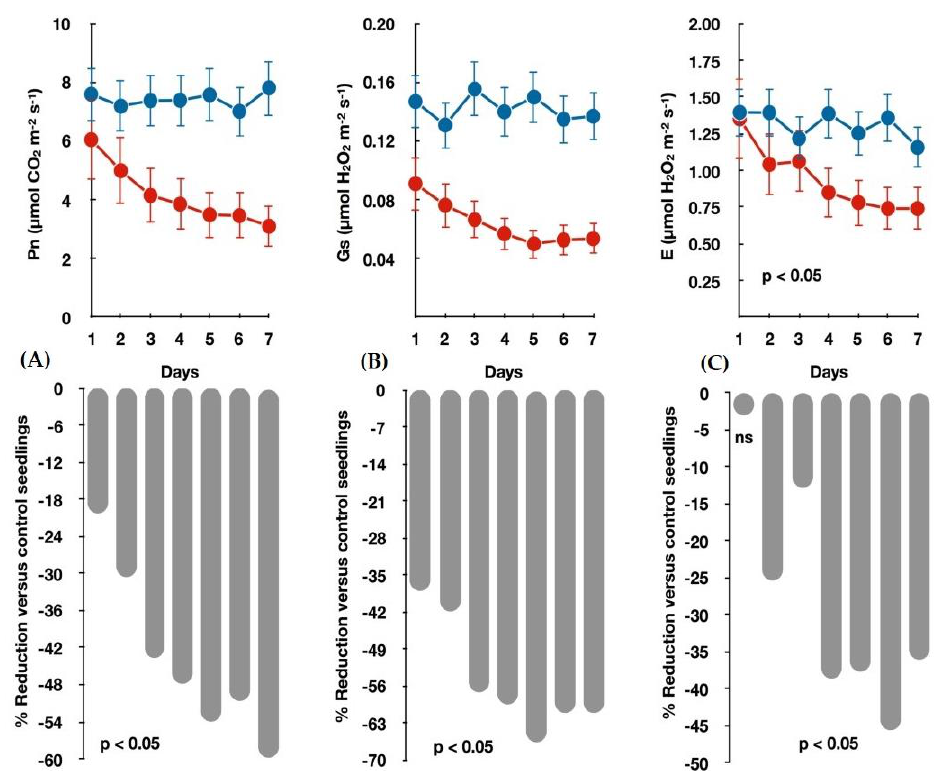
Figure 4. ( A ) Daily seedlings Photosynthesis (Pn), ( B ) Stomatal Conductance (Gs) and (C ) Tran- spiration rate measures and their respective % drop in comparison with control seedlings. Blue lines represent well-watered seedlings; red lines represent water-deficit treated seedlings. Statistical differences, p value < 0.05, between treatments were observed from the second day of the experiment. ns, not significant.